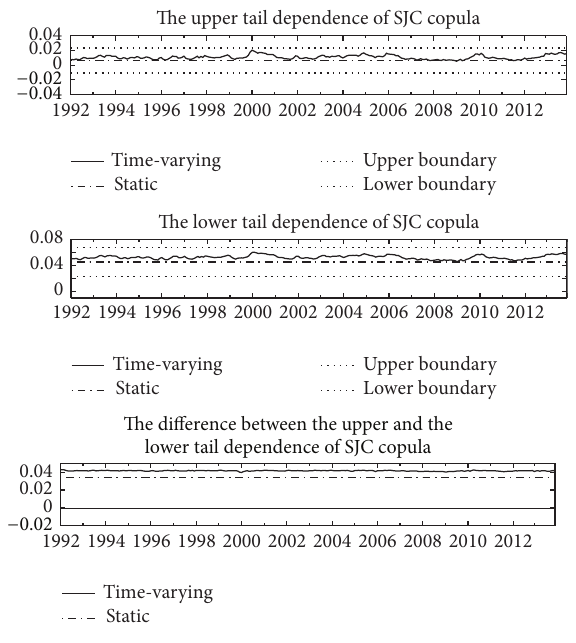
Figure 3: The conditional upper and lower tail dependence in time- varying symmetrized Joe-Clayton copula, with 95% confidence interval for the constant correlation